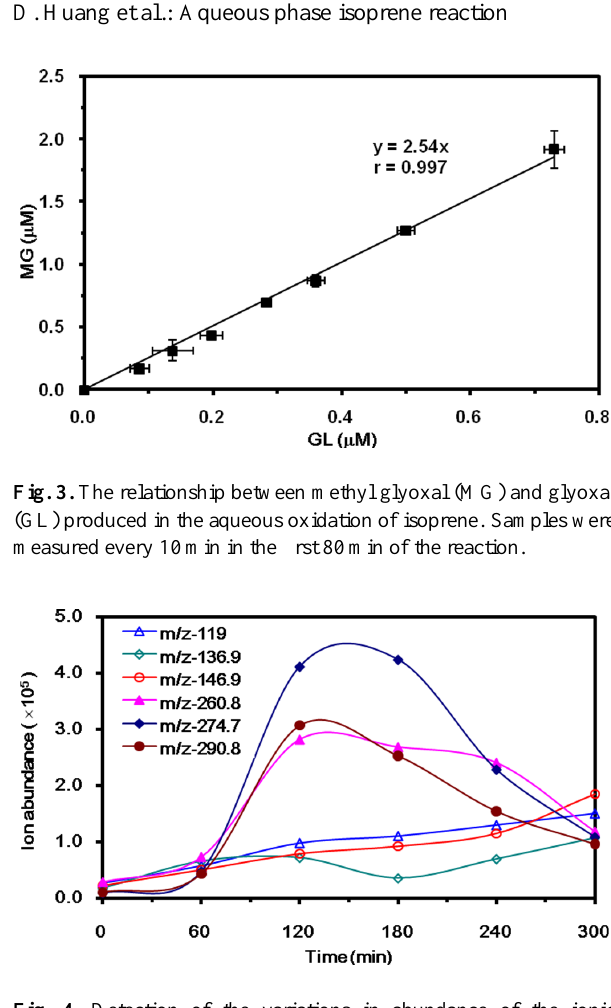
Fig. 4. Detection of the variations in abundance of the ionic molecules produced during the aqueous oxidation of isoprene. m/z , the mass to charge ratio detected by high-performance liquid chromatography-electrospray ionization-mass